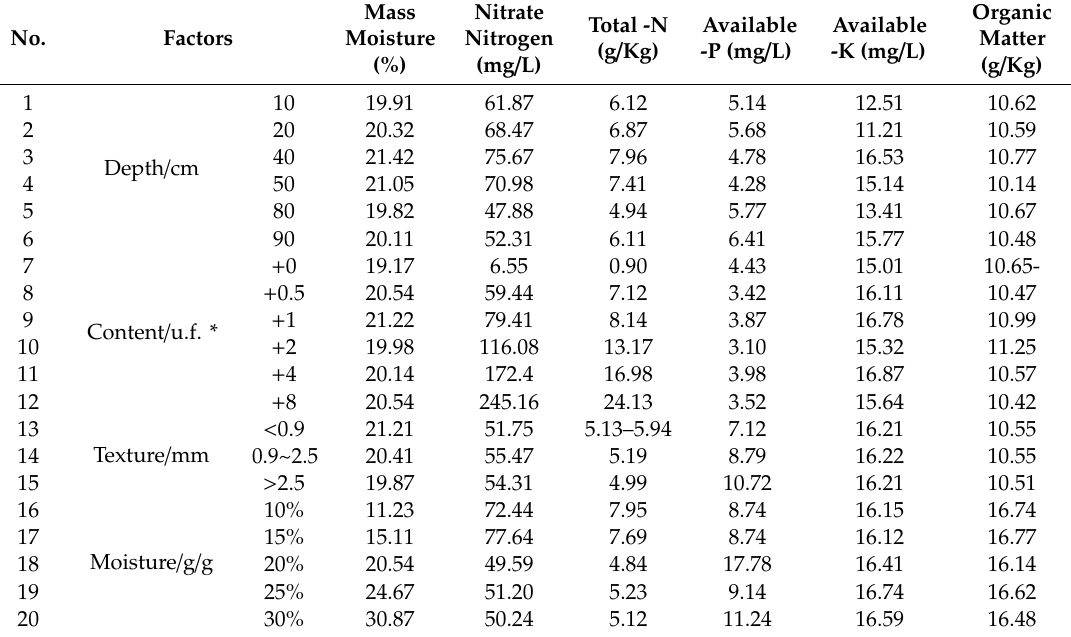
Table 1. The soil